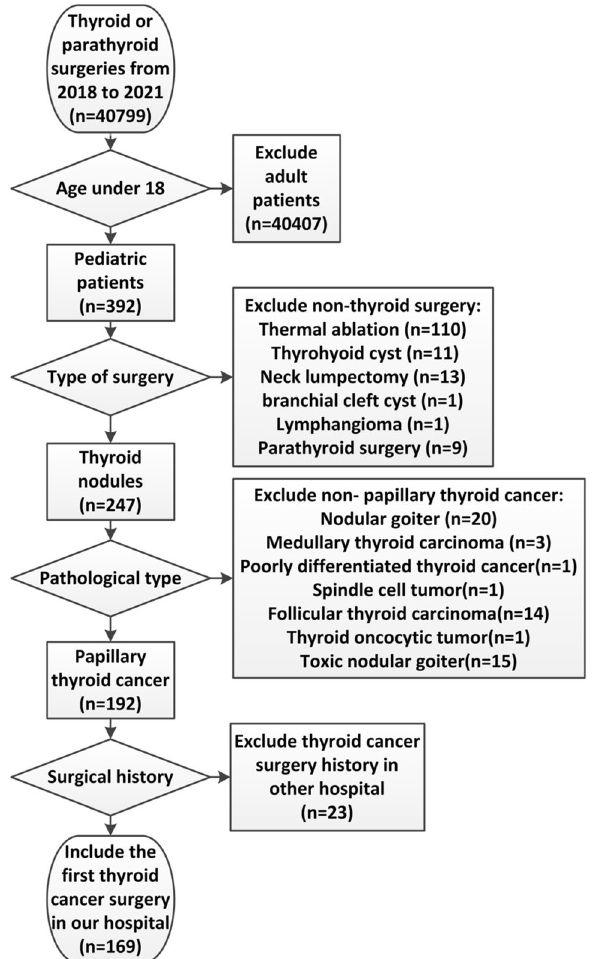
Figure 1. The flow diagram for the inclusion of patients in this